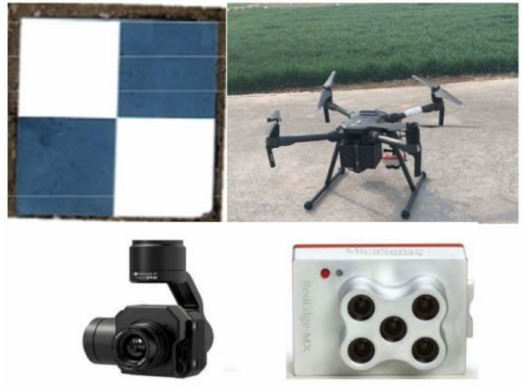
Figure 1. M210 quadrotor with multispectral and thermal